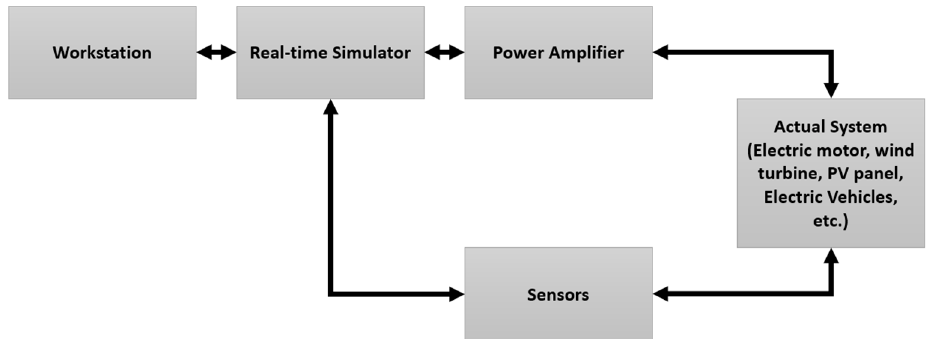
Figure 6. HIL schematic.